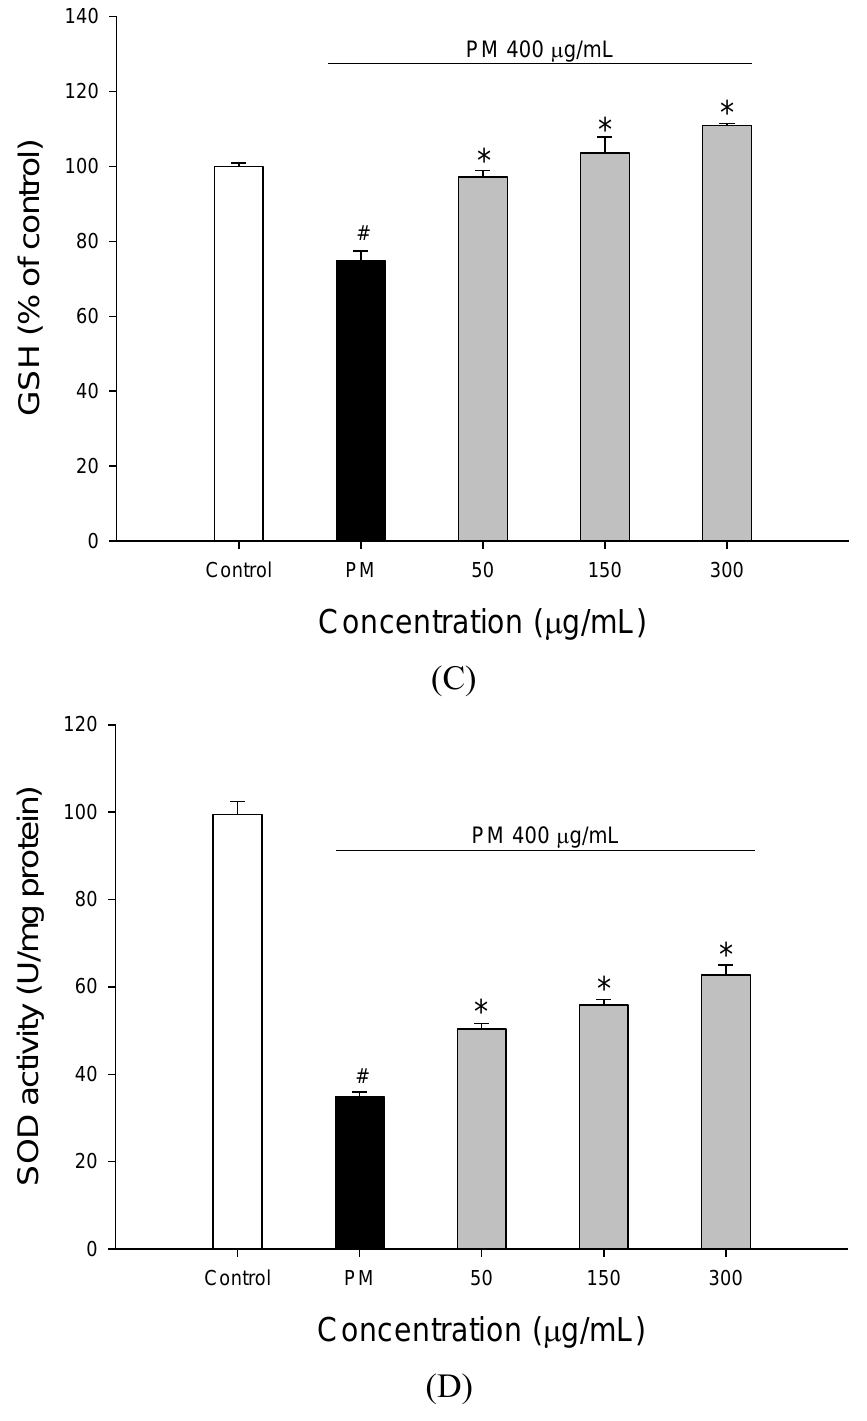
Figure 2. Effects of water extracts of djulis (WECF) on PM-induced oxidation and antioxidant indices in A549 cells. ( A ) Effects of WECF on PM-induced intercellular ROS generation in A549 cells. The cells were treated with WECF and exposed to 400 µ g/mL PM for 2 h. ( B ) Effects of WECF on PM-induced intercellular TBARS formation in A549 cells. The cells were treated with WECF and exposed to 400 µ g/mL PM for 2 h. ( C ) Effects of WECF on PM-induced glutathione (GSH) contents in A549 cells. The cells were treated with WECF and exposed to 400 µ g/mL PM for 20 h. ( D ) Effects of WECF on PM-induced SOD activity in A549 cells. The cells were treated with WECF and exposed to 400 µ g/mL PM for 24 h. # ( p < 0.05) compared with the control group and * ( p < 0.05) compared with 400 µ g/mL PM-induced cells alone. Data are presented as means ± SD ( n =